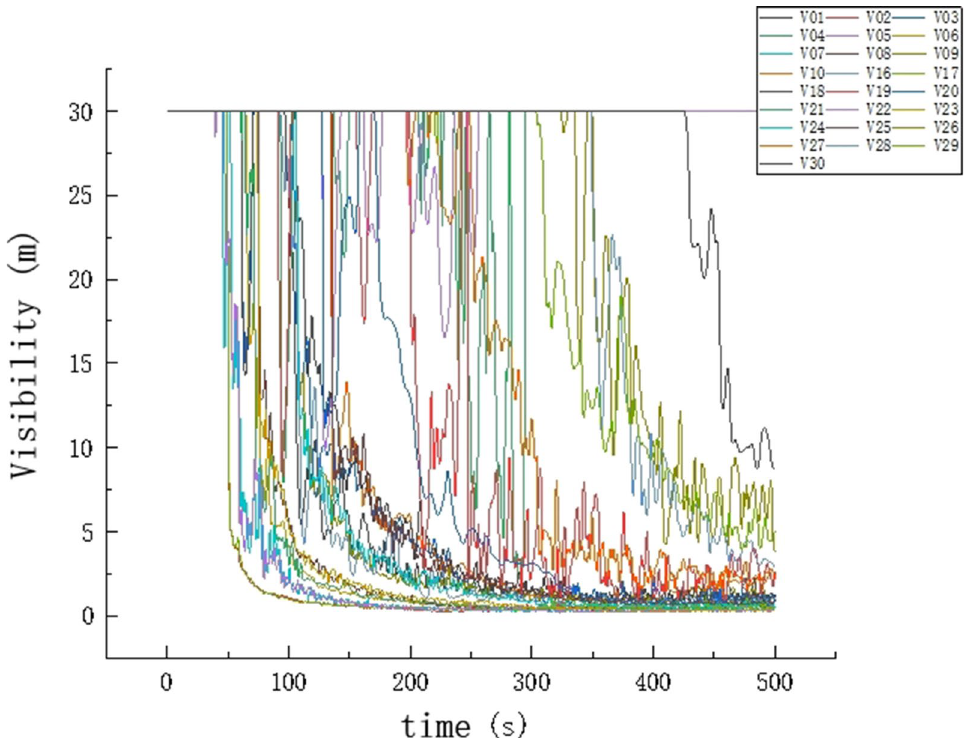
Figure 11. Visibility change chart.